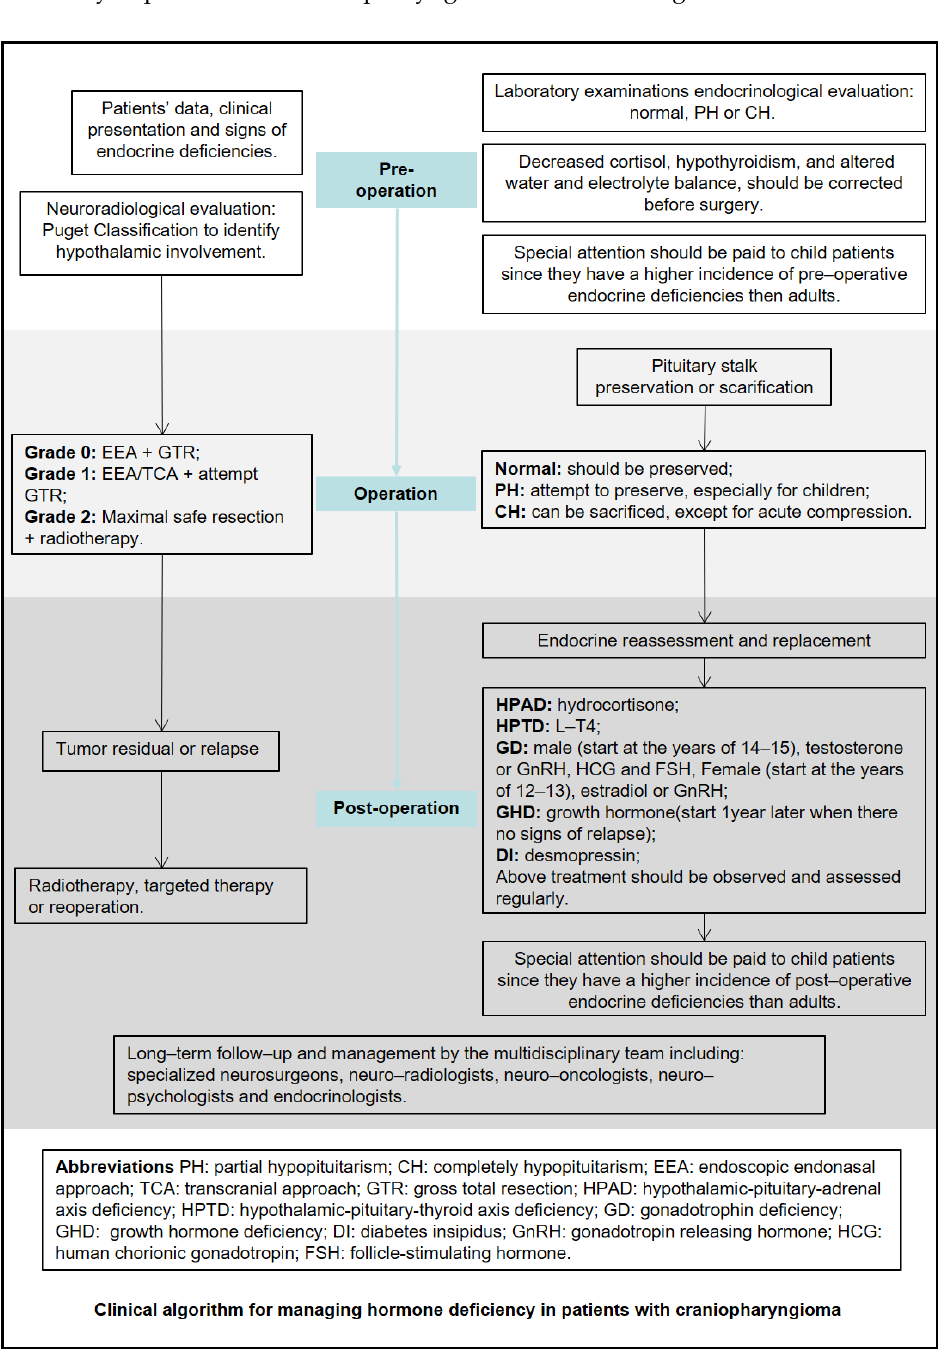
Figure 5. Clinical algorithm for managing hormone deficiency in patients with craniopharyngioma.